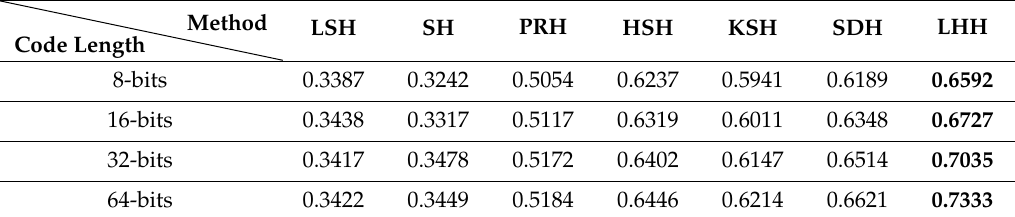
Table 5. Comparison of mAP with di ff erent hash code lengths on SAT6.